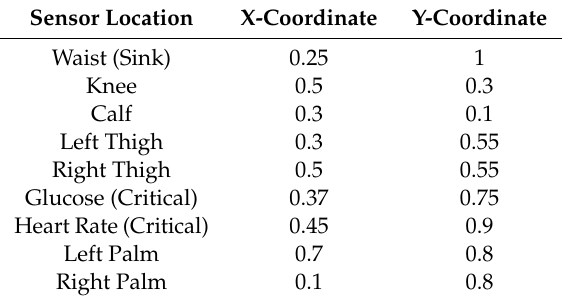
Table 2. Sensor Nodes Deployment.